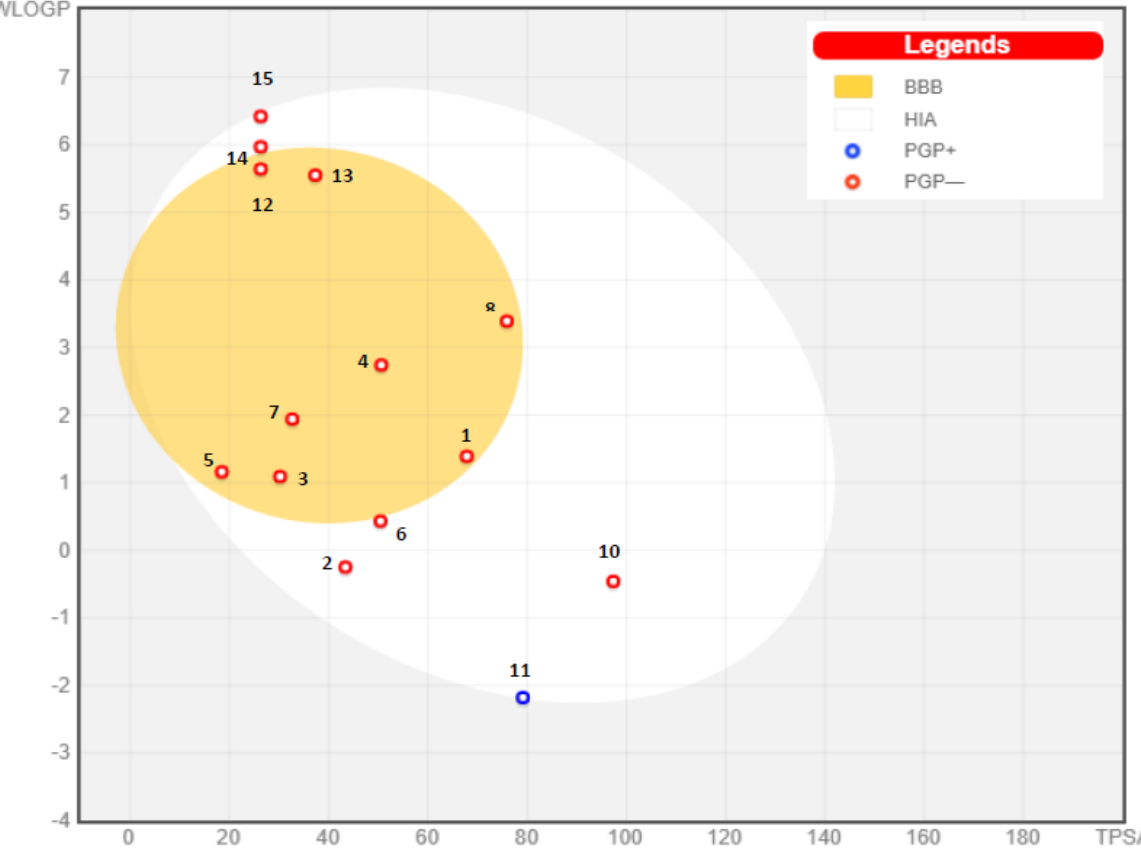
Figure 3. (BOILED–Egg) model of the selected compound. The names of the compounds are listed in Table 1.